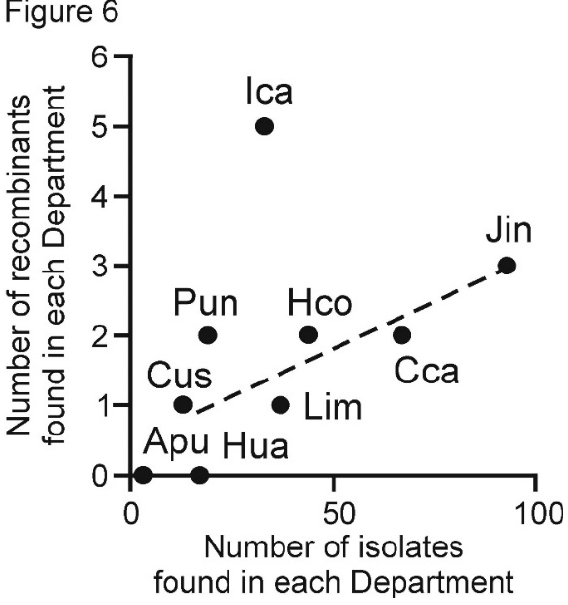
Figure 6. Graph of the number of recombinants found in each Department plotted against the total number of potato virus X isolates collected from each Department.